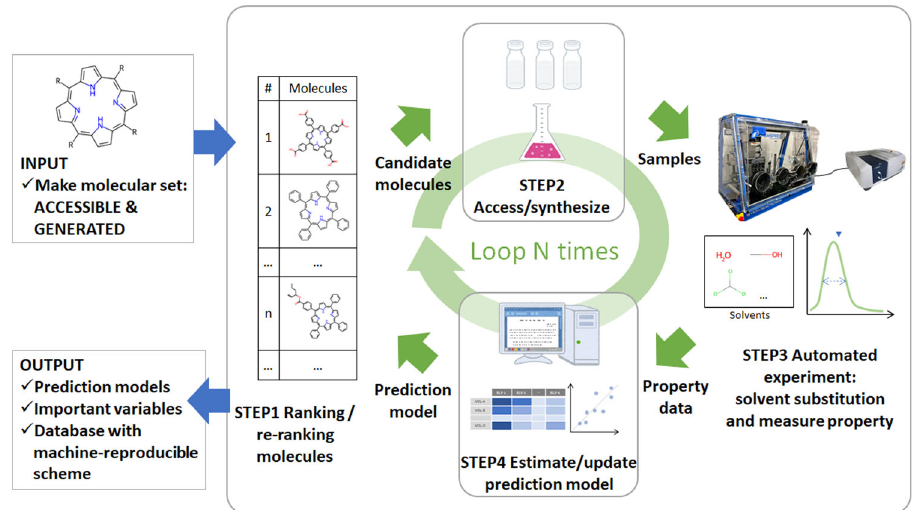
Fig. 3 Semi-automated scheme. STEP1; the priority ranking of the INPUT molecular set was constructed using the SFM algorithm. STEP2; a molecule with the highest priority was accessed or synthesized to prepare a solution for measurement in the following step. STEP3; the system performed UV – Vis absorption spectroscopy to observe the spectrum. STEP4; the system evaluated the four representative indicators from each spectrum and estimated both the qualitative and quantitative prediction models based on the accumulated data.